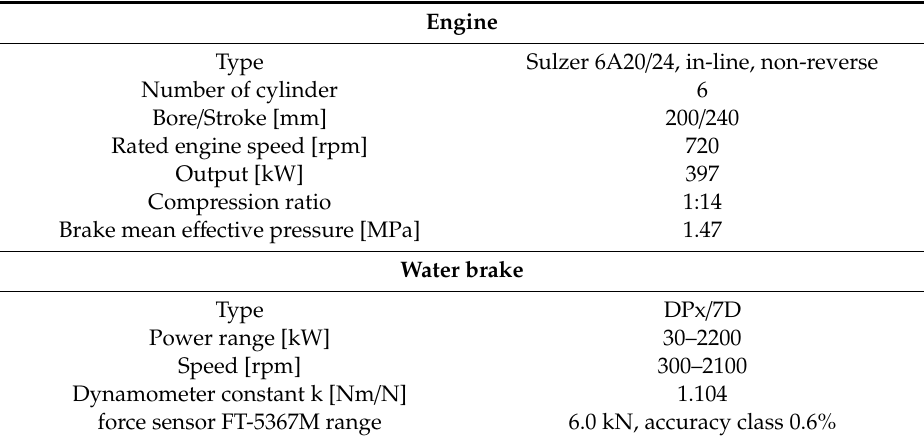
Table 1. Test bed engine and water brake